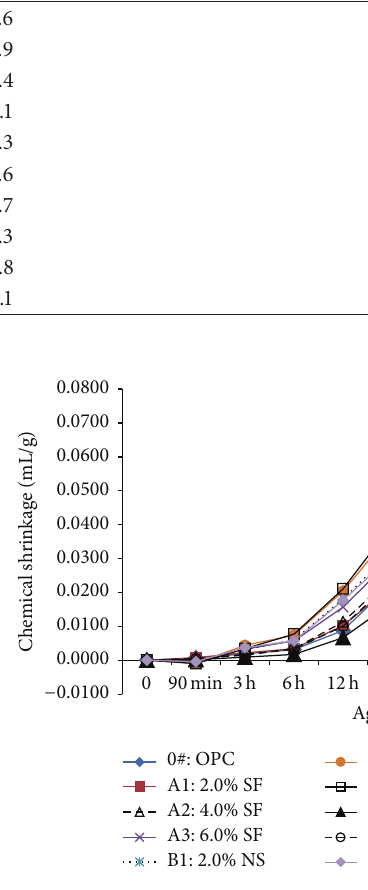
Figure 5: Chemical shrinkage of composite cement pastes at early